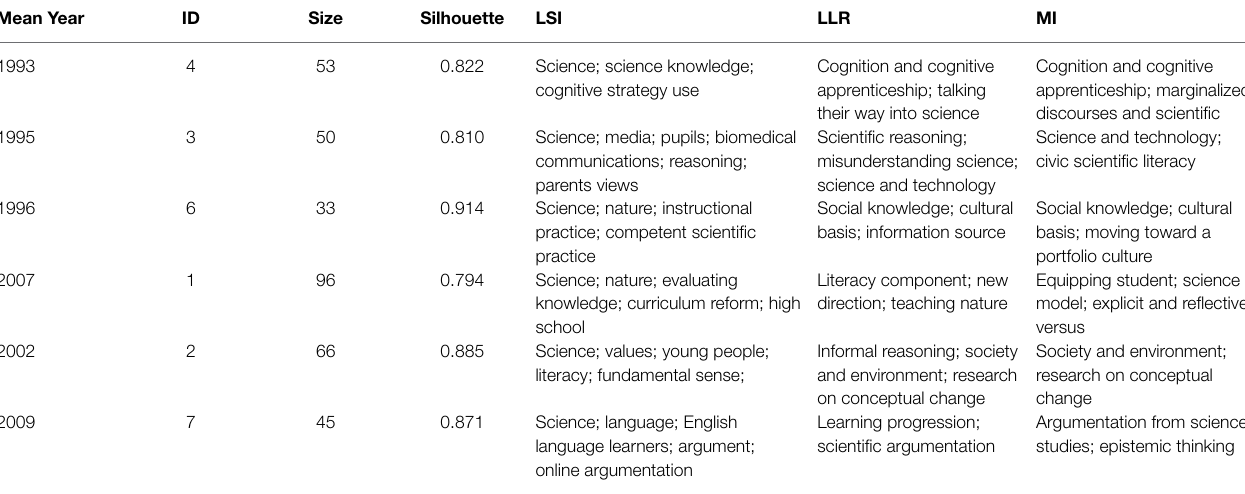
TABLE 2 | Six notable clusters in the intellectual structure of scientific literacy pre and post the year 2000 (1980 to 2019).